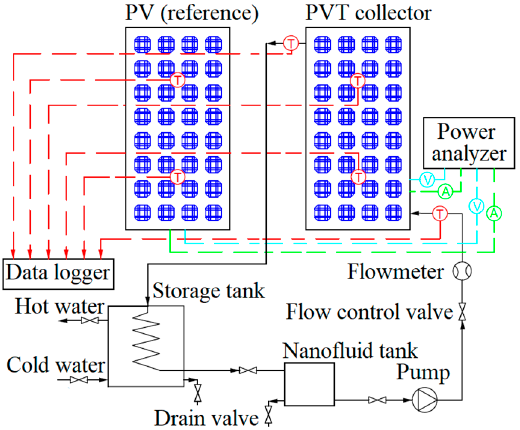
Figure 1. Flow chart of the experimental setup for the PV module and PV/T collector. The PV/T system consisted of a mono-crystalline silicon module with 41.2 × 33.6 cm dimensions and a heat extraction unit laminated with the back surface of the PV module